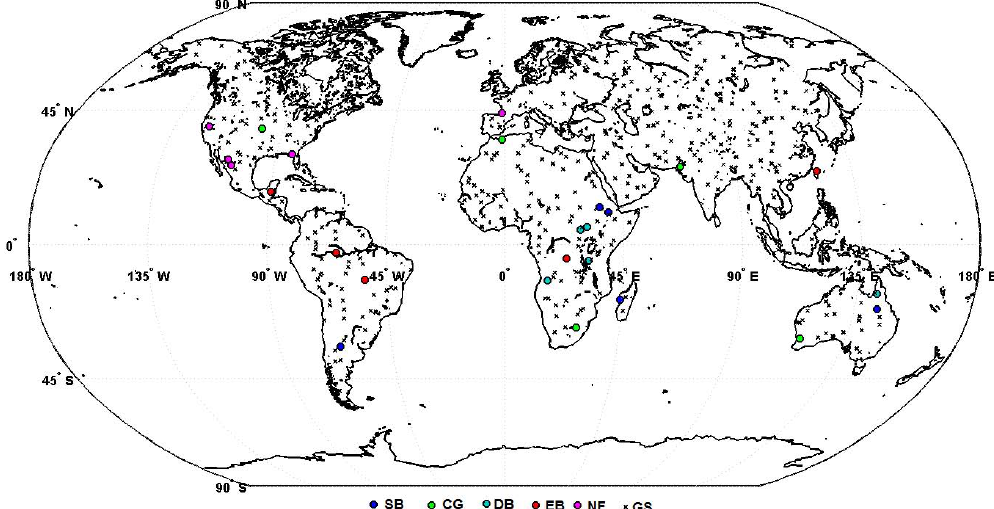
Fig. 2. Location of the 25 sites being selected ( ◦ ) (Table 2) and the 384 sites used to simulate gaps in the data ( × ). SB: shrub savannah bare, GC: crop grassland, DB: deciduous broadleaf forests, EB: evergreen broadleaf forests, NF: needleleaf forests.